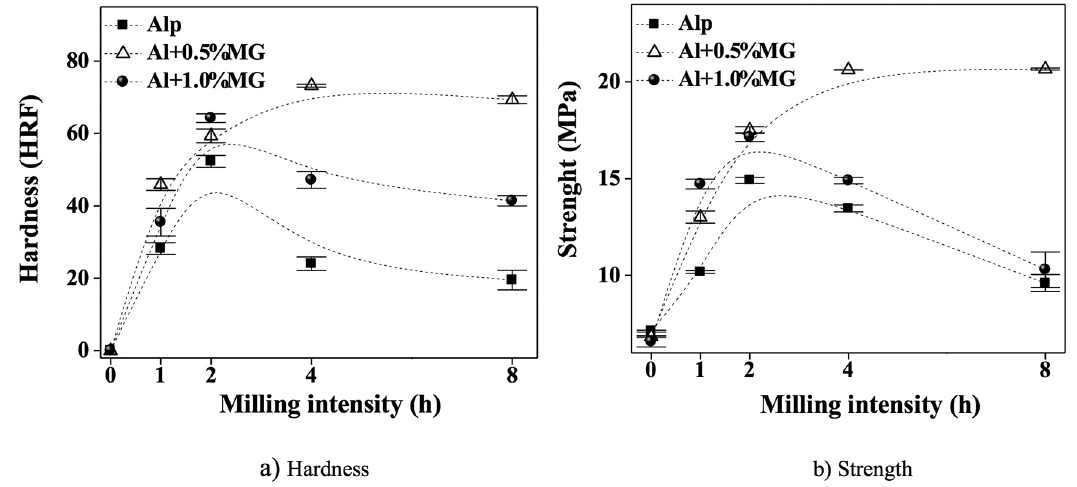
Figure 6. Mechanical response of composites: a) Hardness and b) strength as a function of milling